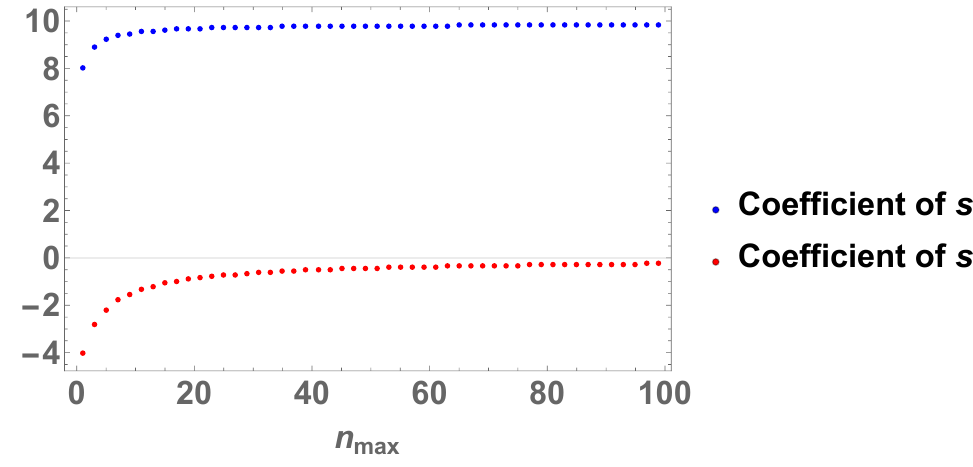
Figure 2 . The coe(cid:14)cients of s 2 (blue) and s 2 t (red) obtained after summing up over n from 1 to n max : As the positivity bound implies, each sector labeled by n contributes to the s 2 coe(cid:14)cient positively. On the other hand, the n = 1 sector gives a negative contribution to the s 2 t coe(cid:14)cient, which is canceled by positive contributions from n (cid:21) 3 to obtain a vanishing coe(cid:14)cient in the limit n max ! 1 representing the open superstring